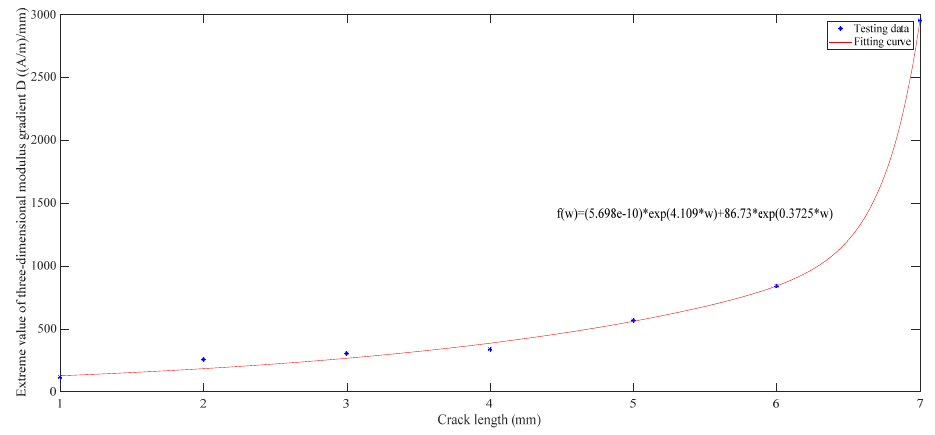
Figure 10. Variation curve of three-dimensional magnetic modulus gradient with defect size.